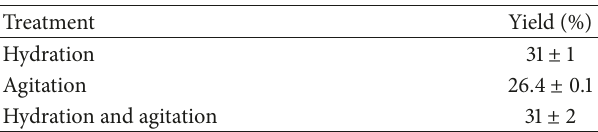
Table 3: Mucilage yields via nonthermal extraction from O. coche- nillifera cladodes.